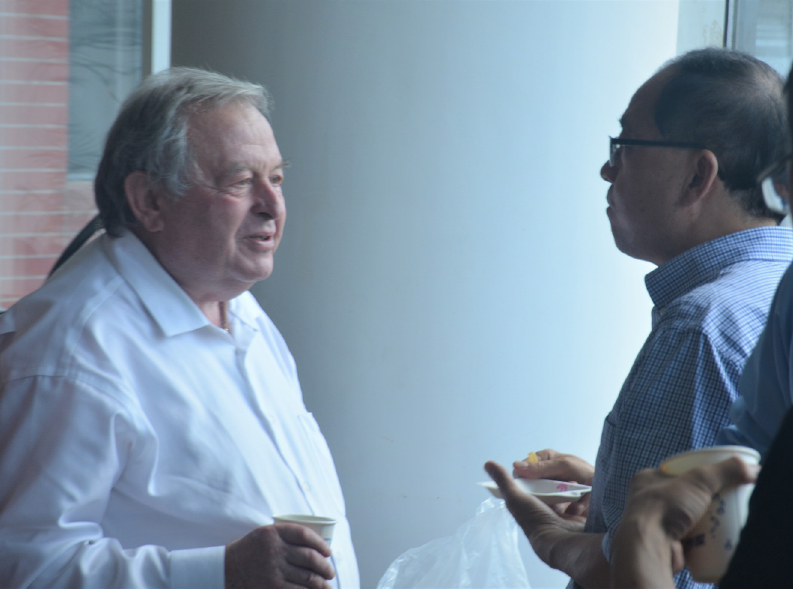
Figure 3: Mark Stockman and I were having a conversation during our last meeting